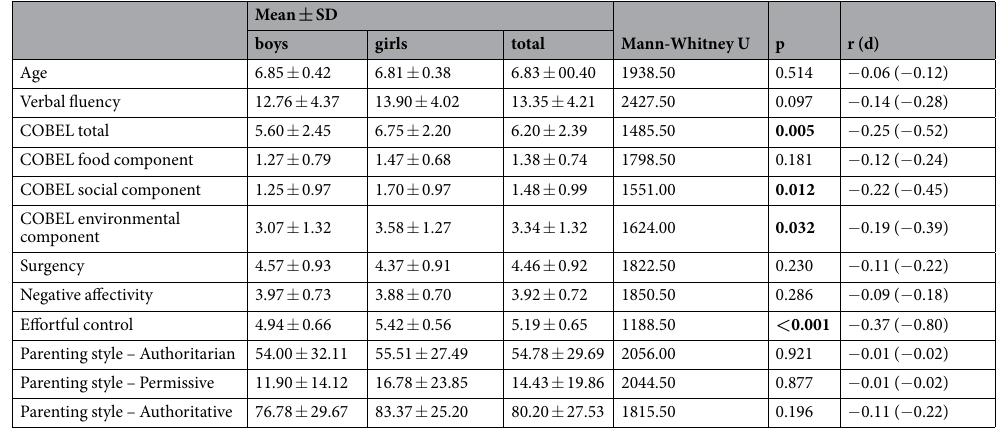
Table 1. Descriptive statistics for boys, girls, and the total sample, Mann-Whitney U for differences between boys and girls, p value, and effect size r , which was converted to Cohen’s d